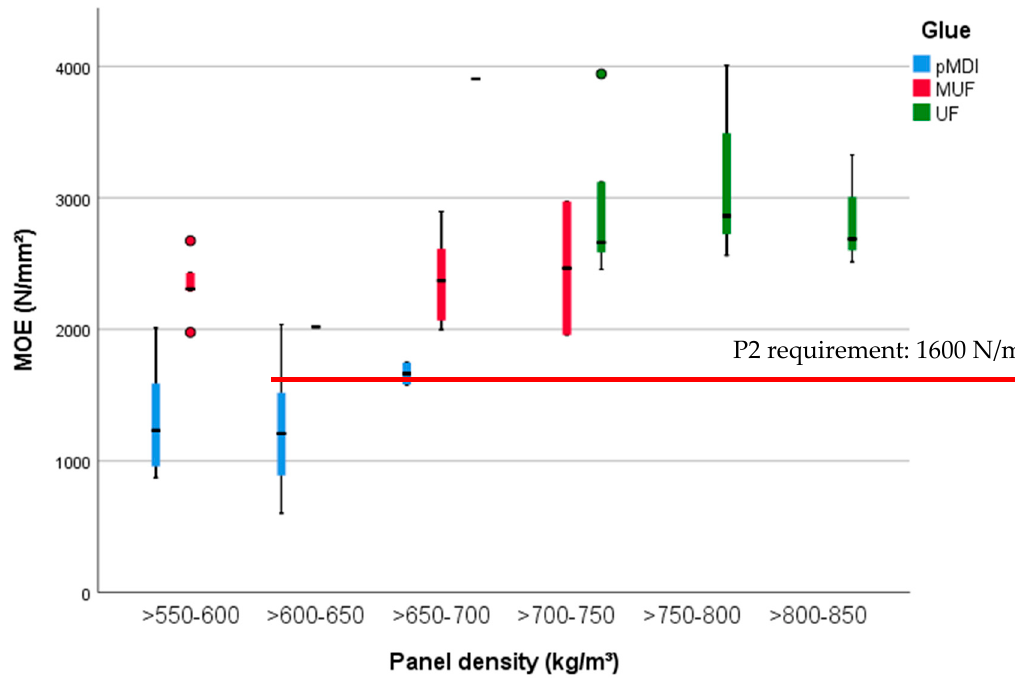
Figure 6. MOE of the 15 mm PB samples with densities between 500 and 850 kg/m³ and glued with pMDI, UF and MUF.